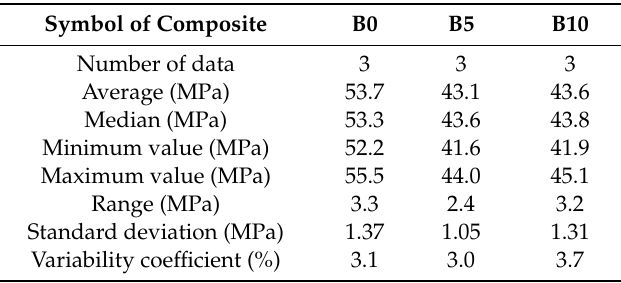
Table 8. Basic statistical parameters. Characteristics of concrete composite after 28 days.